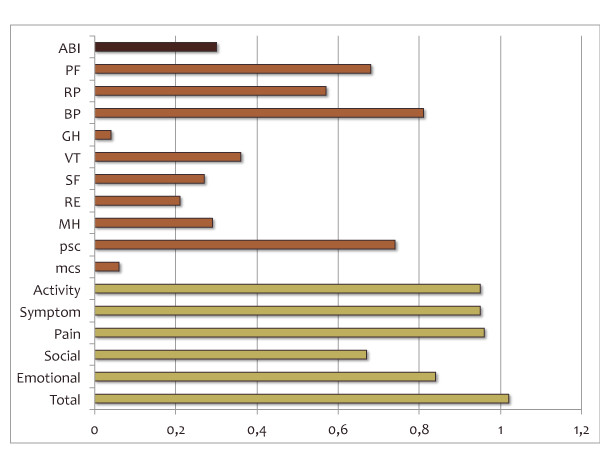
Standardized response mean (SRM) after vascular intervention; for ABI (ankle-brachial index) and the different VascuQoL and SF-36 subscales.ABI = ankle-brachial index; PF = physical functioning; RP = role physical; BP = bodily pain; GH = general health; VT = vitality; SF = social functioning; RE = role emotional MH = mental health; PCS = physical health summary and MCS = mental health summary. Cohen’s criteria for interpreting effect size: 0,0–0,2 = trivial; 0,2–0,5 = small; 0,5–0,8 = moderate; >0,8 = large.